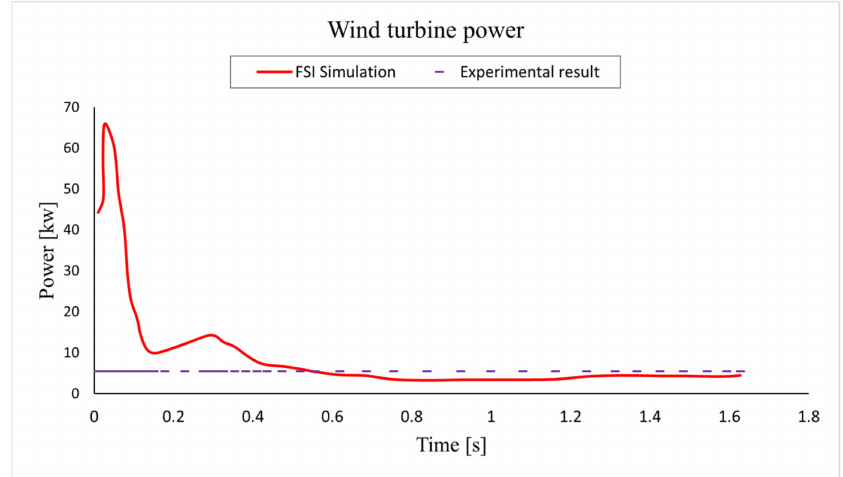
Figure 10. Wind turbine power from the FSI simulation and the experimental one for 7